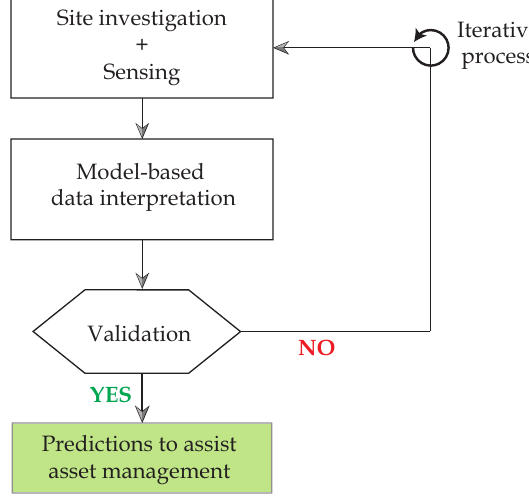
Figure 1. Flowchart detailing typical steps involved in use of model-based data-interpretation methodologies for asset